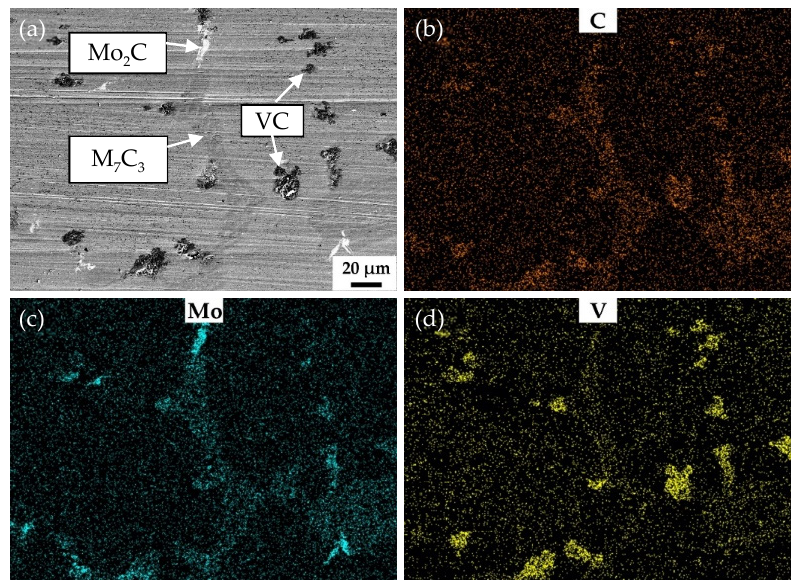
Figure 8. SEM and EDS mapping images of the surface of V3 quenched at 900 °C and tempered at 250 °C after abrasive wear test. ( a ) SEM image, ( b ), ( c ) and ( d ) EDS mapping images of C, Mo and V, respectively.